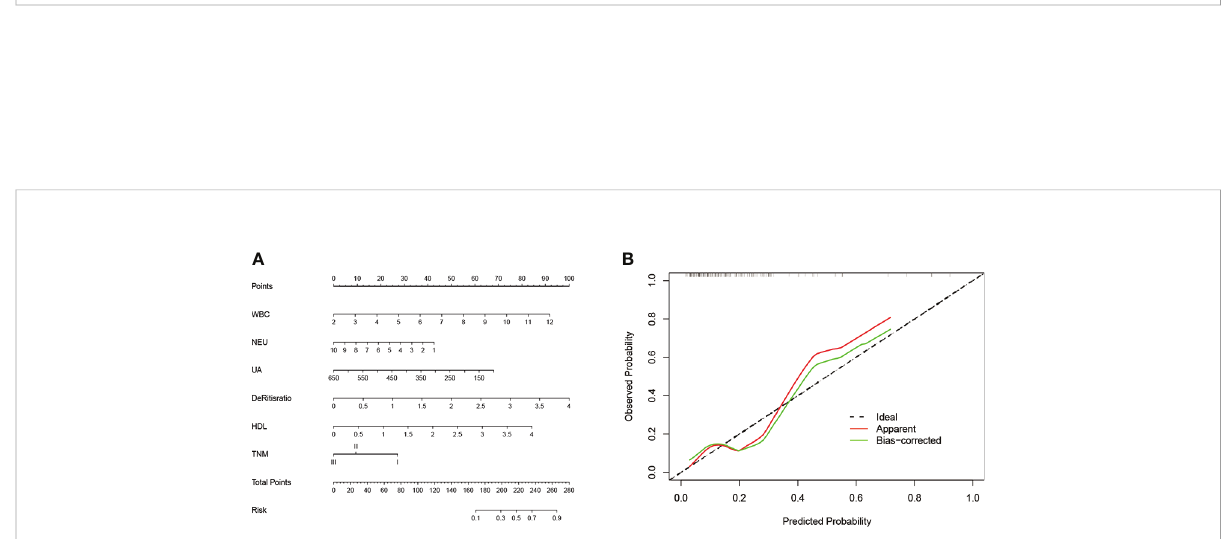
FIGURE 5 (A) The nomogram predicting cHER2 statue in patients with HER2- primary tumor. (B) Calibration curve for predicting cHER2 statue in patients with HER2- primary tumor. Note: WBC (×10 9 /L); NEUs (×10 9 /L), PLT (×10 9 /L), UA